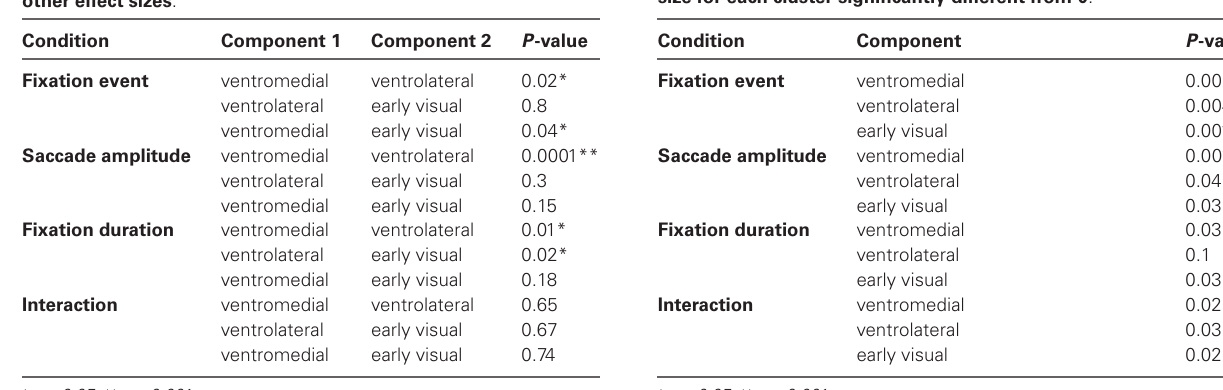
show effect sizes in the parametric GLM for: (1) the main effect of a fixation, (2) saccadic amplitude modulation, (3) fixation duration modulation, and (4) the interaction between fixation duration and saccadic amplitude. Error bars denote standard error of the mean over subjects.